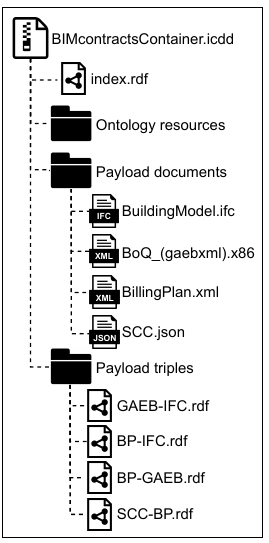
Figure 3. File structure of the BIMcontracts Container